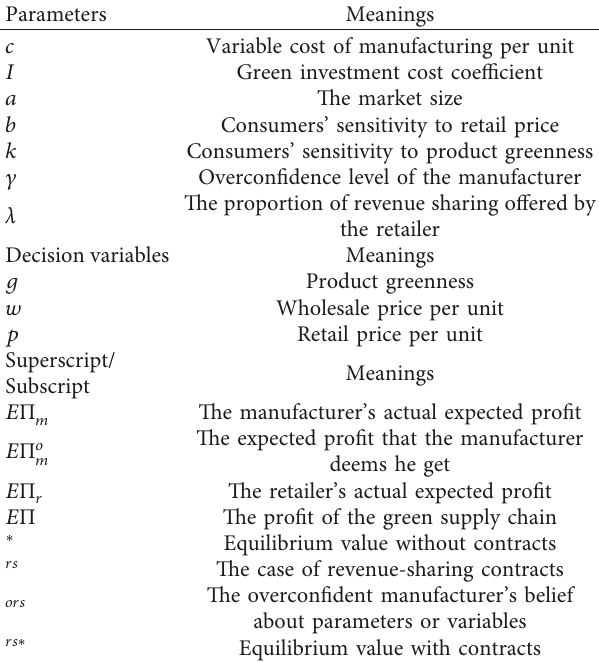
Table 1: List of the main